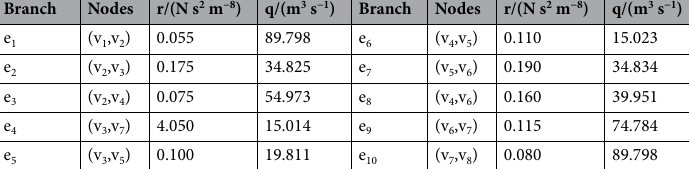
Table 2. The branching parameters of the T-shaped angle-joint ventilation network.